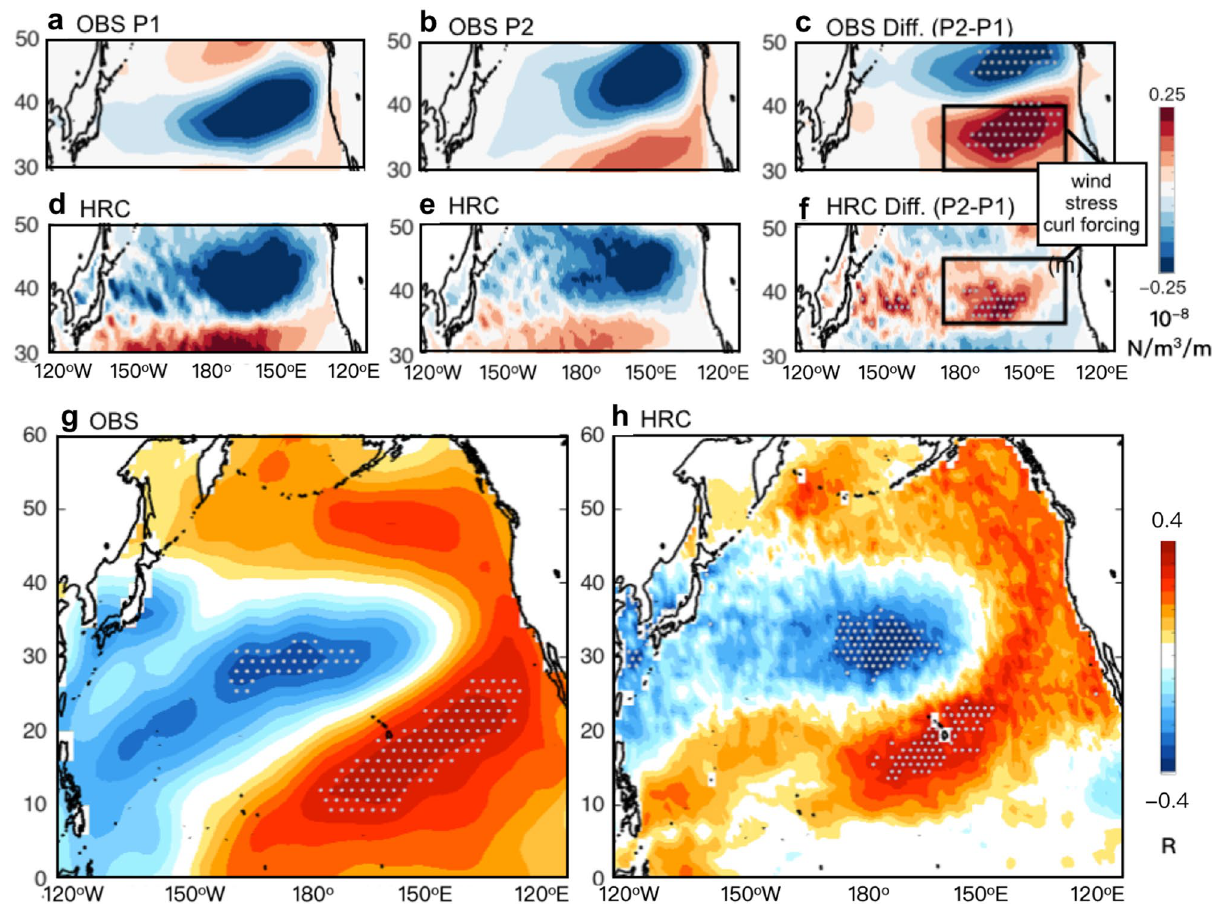
Figure 5. Observed and simulated changes in the KE atmospheric downstream response from the P1 to P2 Patterns of leading Curl SVD mode between KE SSH and midlatitude Curl (12mon-lagged) for the ( a ) Period 1 and ( b ) Period 2 and its difference ( c ) in observations. ( d – f ) Same as ( a – c ), but for in HRC. ( g , h ) Correlation map of SST anomalies with the time series of subtropical wind forcing (black box of d and g ) that is computed by regressing the target patterns (black box of c and f ) onto the original wind stress curl anomalies. The figures are provided using MATLAB R2017a (https:// www. mathw orks. com/ produ cts/ new_ produ cts/ relea se201 7a.